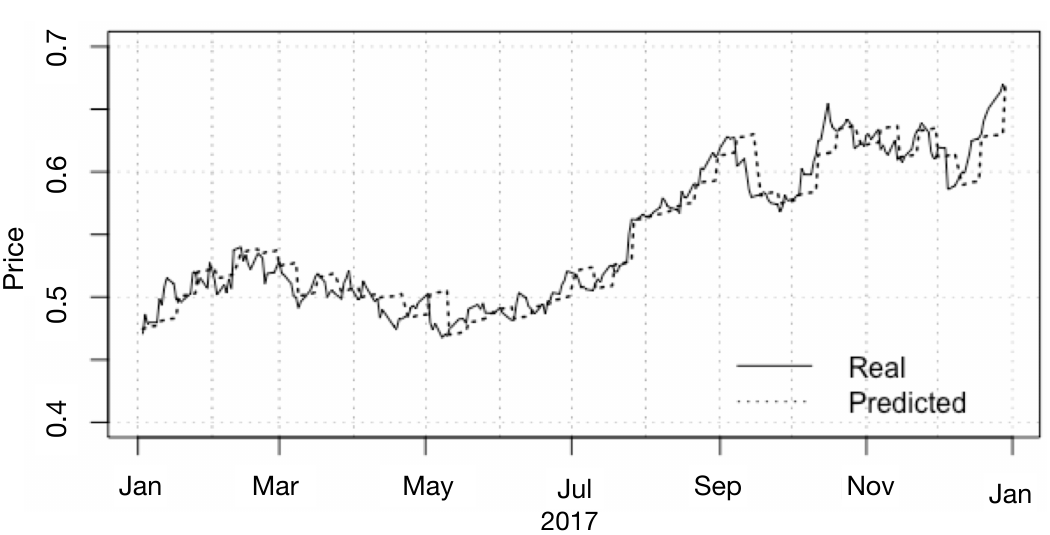
Figure 3. Example of a five-day prediction in 2017. The solid line is the original series. The dotted line is the